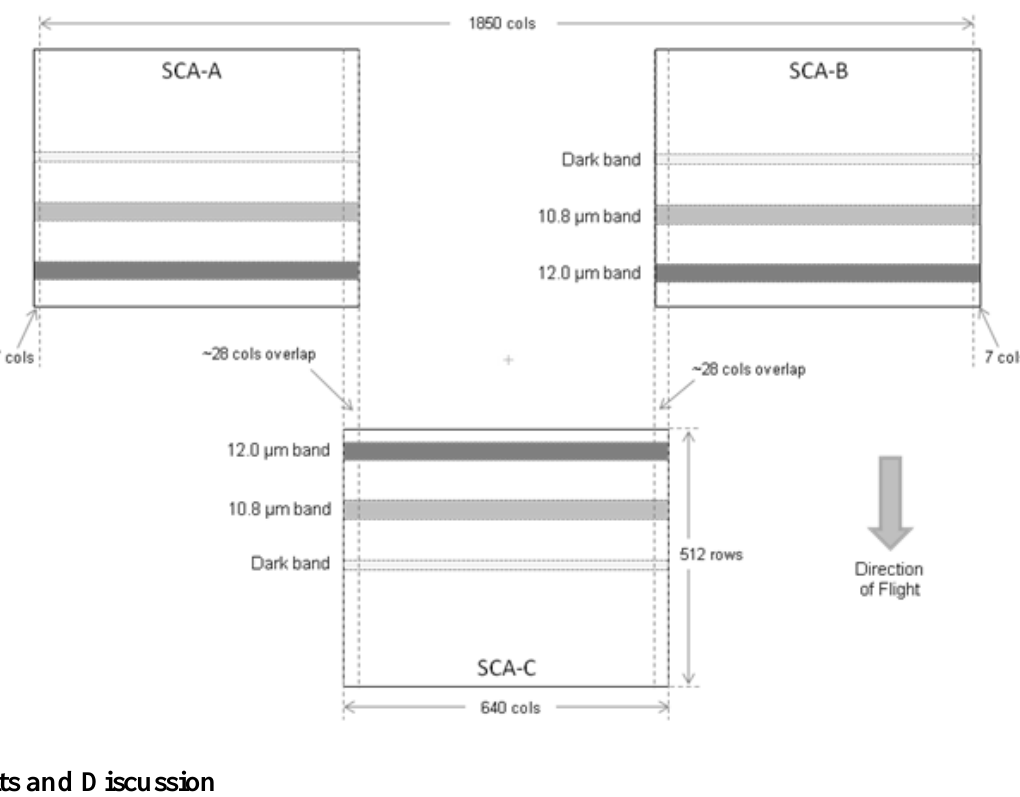
Figure 1. Illustration of the Thermal Infrared Sensor (TIRS) focal plane layout. Three Quantum Well Infrared Photodetector (QWIP) arrays containing 512 by 640 detectors make up the focal plane. Spectral filters and masks are placed over specific areas of each QWIP to produce the two TIRS spectral channels and the blind band. Data from the filtered regions on the three QWIP arrays are combined to produce an effective across-track linear imaging array of 1,850 detectors per band by discarding approximately 7 columns on either end of the line and allowing for approximately 28 columns of overlap between adjacent